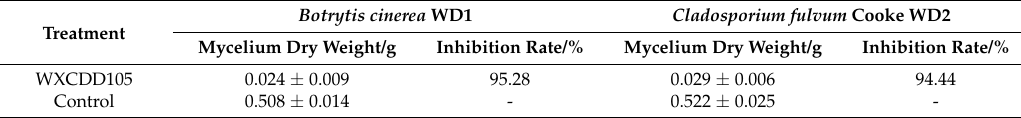
Table 3. Inhibitory effects of sterile filtrate of strain WXCDD105 on mycelial growth of pathogenic fungi.